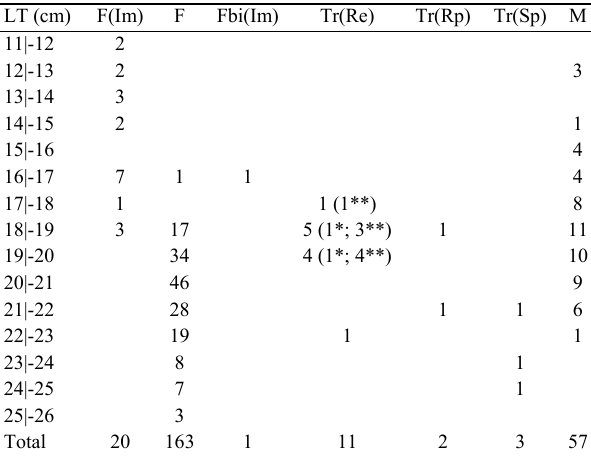
Table 4. Classification of Alphestes afer by gonad class and size from March 2008 until February 2010. Fbi(Im), bisexual phase of immature female; F, ovarian phase of resting, ripe and spent female; Tr(Re), transitional phase of resting female; Tr(Rp), transitional phase of ripe female; Tr(Sp), transitional phase of spent female; M, testicular phase of ripe, spent and resting male; (*) individuals without MB; (**) individuals with spermatic sinus (Total =